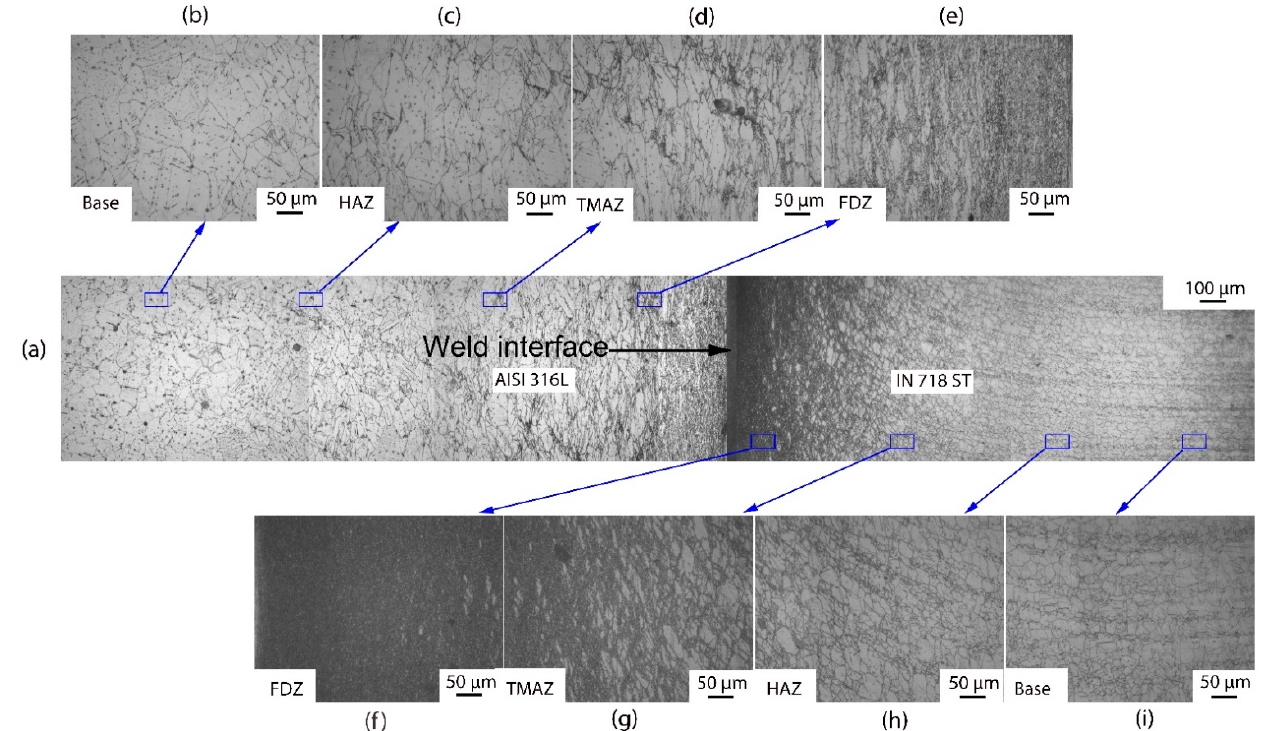
Figure 5. Cross-sectional view of weld joint interface of dissimilar friction weld AISI 316L-IN718 ST condition ( a ) weld interface; ( b ) base metal on AISI 316L side; ( c ) HAZ on AISI 316L side; ( d ) TMAZ on AISI 316L side; ( e ) FDZ on AISI 316L side; ( f ) FDZ on IN718 side; ( g ) TMAZ on IN718 side; ( h ) HAZ on IN718 side; and ( i ) base metal on IN718 side.